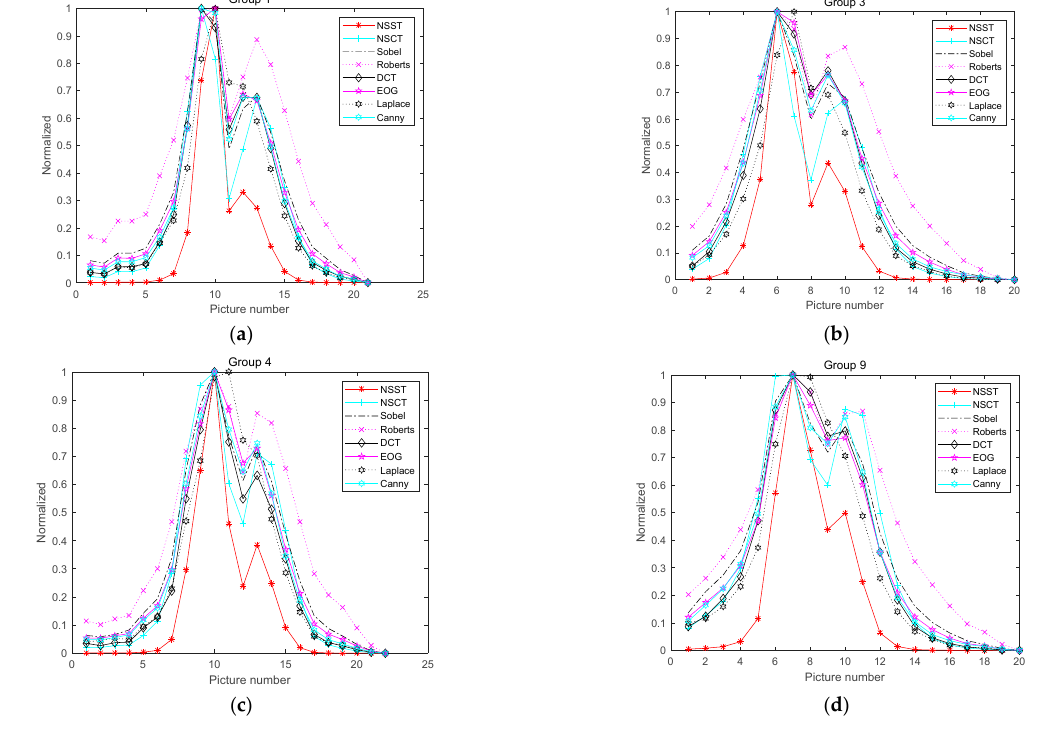
Figure 5. Sharpness evaluation curve of each algorithm for the four groups of images: ( a ) Group 1; ( b ) Group 3; ( c ) Group 4; ( d ) Group 9.